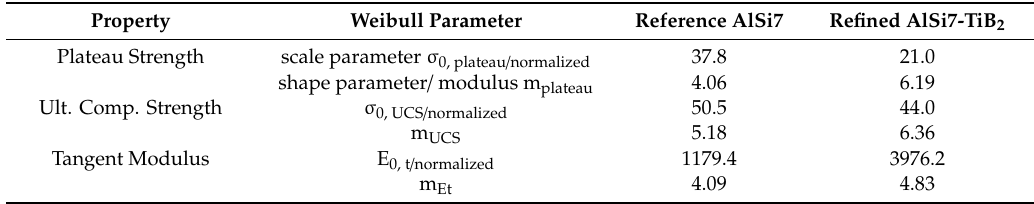
Table 6. Compression test results, comparison of Weibull distribution parameters for AlSi7 foam with and without TiB 2 grain refiner with as received TiH 2 as foaming